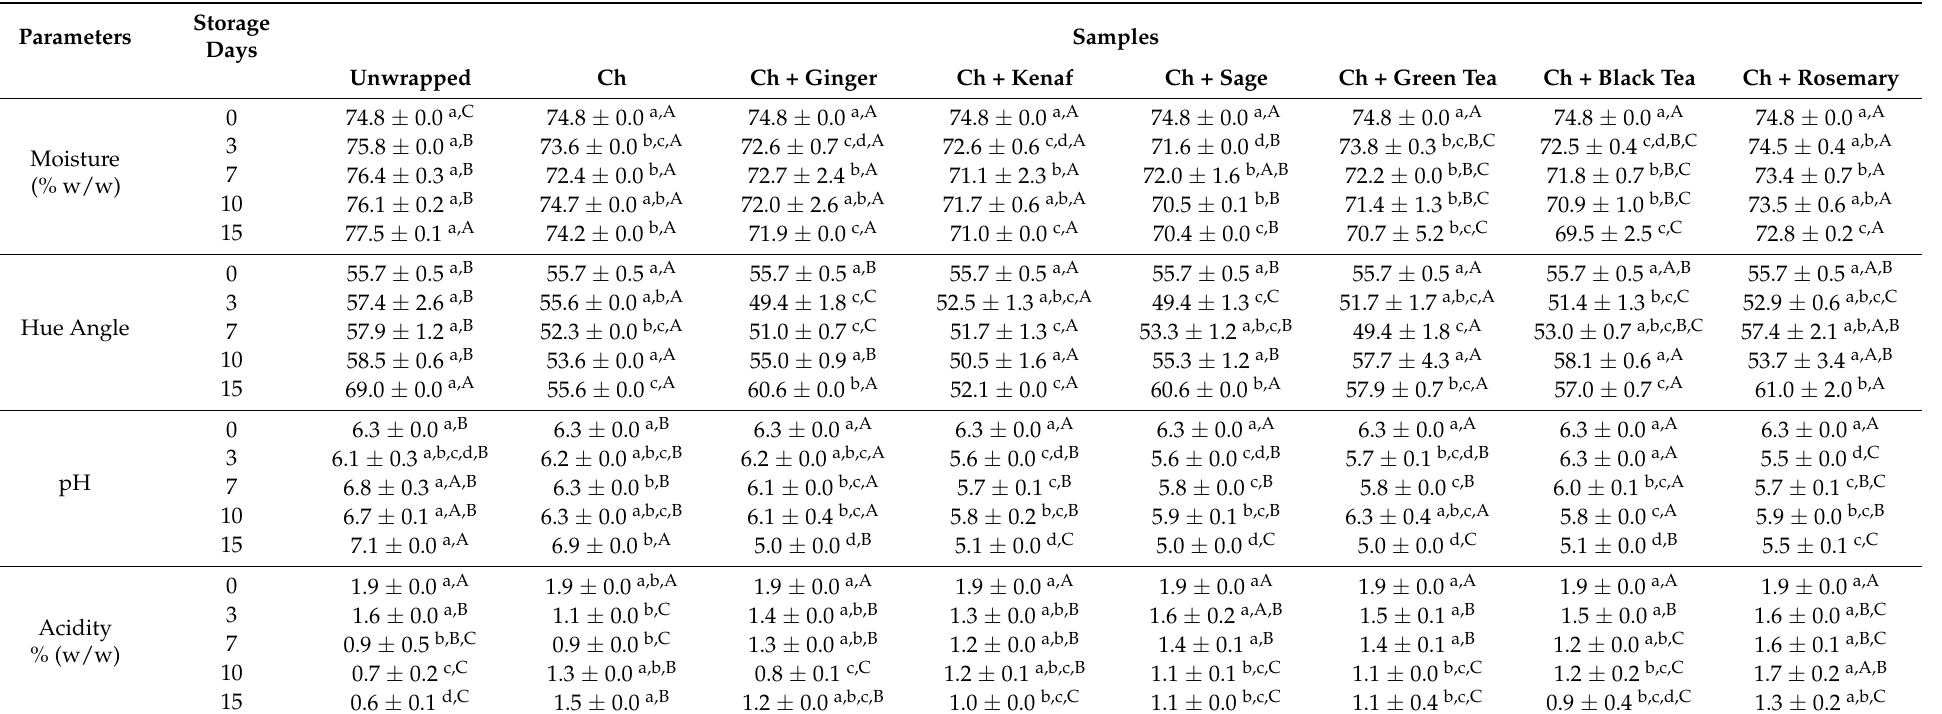
Table 1. Physical and chemical results of the poultry meat over the shelf-life